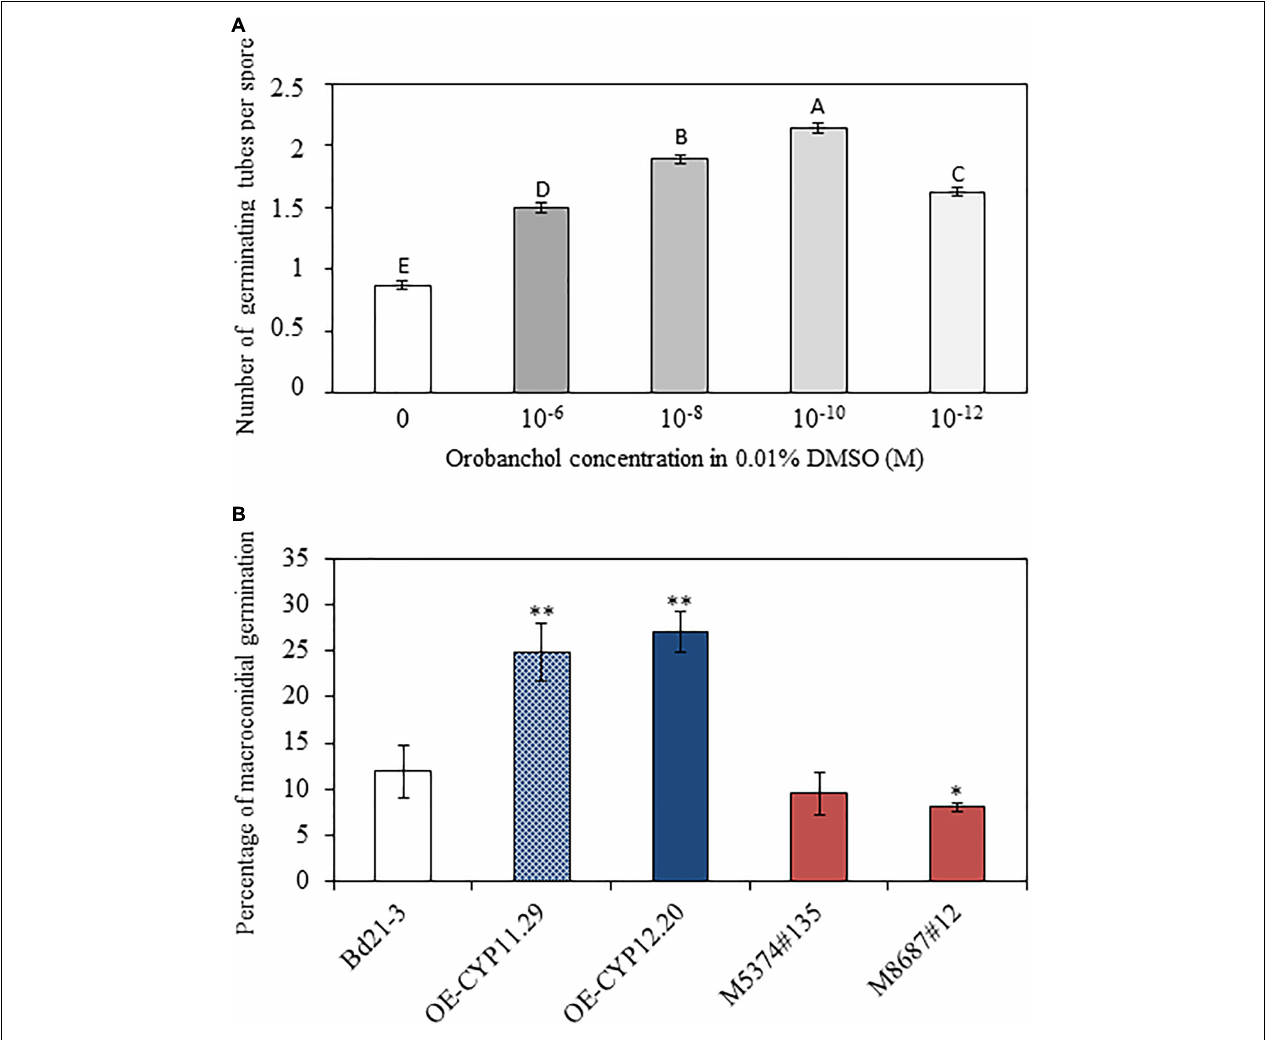
FIGURE 9 | Orobanchol promotes spore germination of F. graminearum . (A) Counting of germinating tubes developed by macroconidia of the F. graminearum FgDON + strain 12h after incubation on agar medium containing different concentrations of orobanchol. 0.01% DMSO was used as a negative control as it corresponds to the dilution solution of orobanchol. Counts were performed on at least 500 macroconidia per condition and repeated in three biological replicates. Different letters indicate statistically significant differences ( p- value < 0.01, Tukey’s test). (B) Percentage of macroconidial germination of the F. graminearum FgDON + strain 12 h after incubation in exudates of the different B. distachyon lines. Asterisks indicate significant differences compared to the wild-type line Bd21-3 (* p -value < 0.05, **p -value < 0.001, Student’s t-